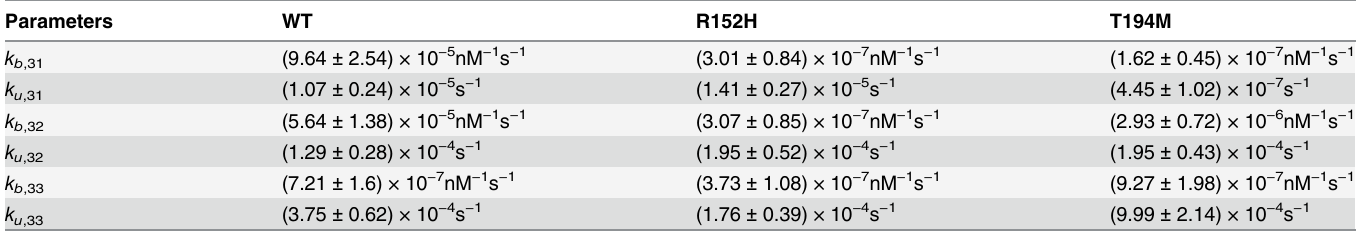
Table 5. List of optimized parameters used for the simulation of in vitro transcription assay of bipA . Here, x ± y stand for the value of optimized param- eter x with standard deviation y . The standard deviation is calculated using the data of 500 independent SA runs.